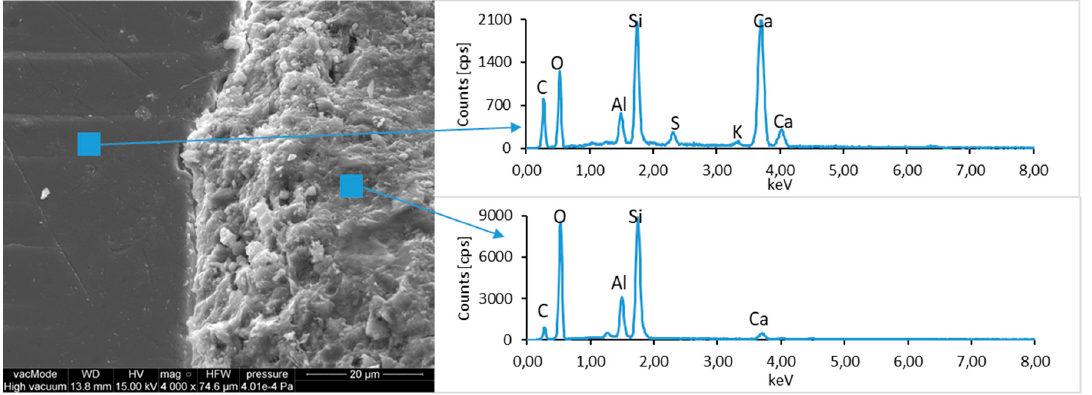
Figure 17. SEM micro-structure of CI.1 concrete and results of elemental analysis in EDS micro-area (1—glassy LCD; 2—paste; strong interface between them is apparent. Materials 2019 , 11 , x FOR PEER REVIEW 17 of 22